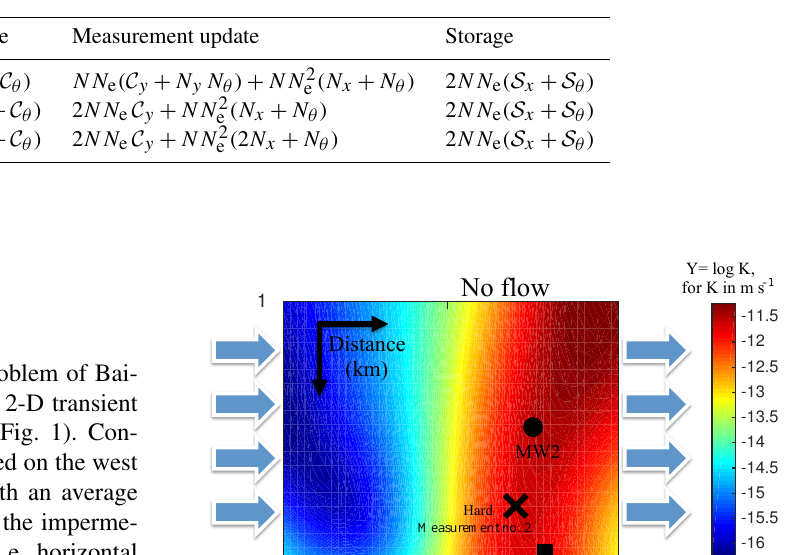
Table 1. Approximate computational complexities of the joint EnKF, the dual EnKF, and the dual EnKF OSA algorithms. Notations are as follows. N x : number of state variables, N θ : number of parameter variables, N y : number of observations, N : number of assimilation cycles, N e : ensemble size, C x : state model cost (i.e., N 2 x is the linear KF), C θ : parameter model cost (usually free ≡ identity), C y : observation operator cost (i.e., N y N x in the linear KF), S x : storage volume for one state vector, and S θ : storage volume for one parameter vector.